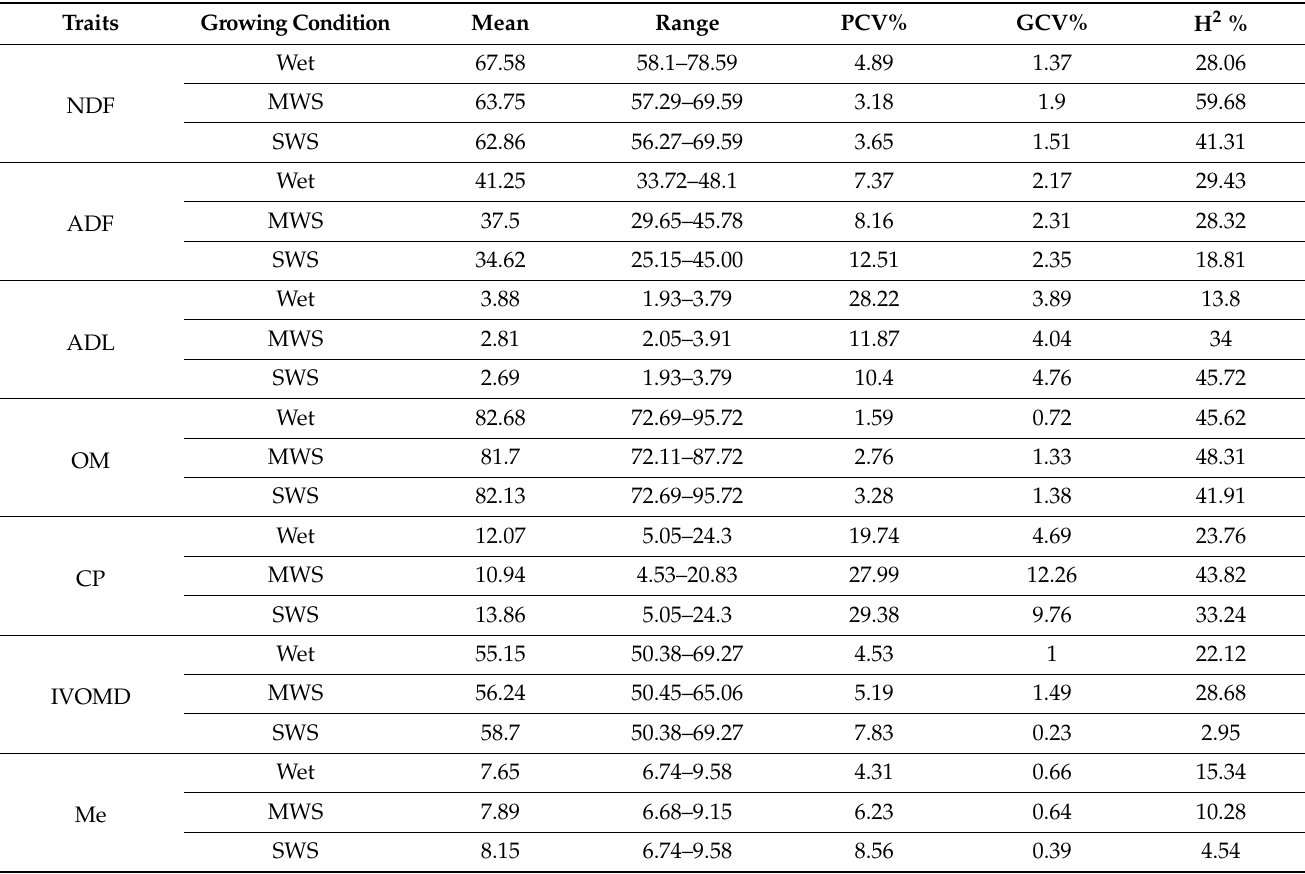
Table 4. Variations and heritability of the feed quality traits of 84 Napier grass genotypes grown under rainy season (wet) and dry season conditions—either exposed to moderate water stress (MWS) or severe water stress (SWS)—for two